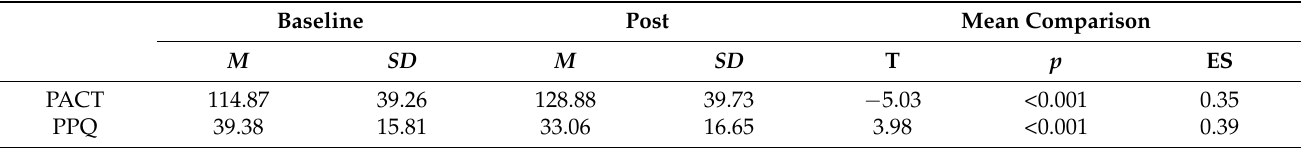
Table 4. Means and standard deviations of physical performance (PACT) and pain-related psycholog- ical impairment (PPQ) before and after outpatient orthopedic rehabilitation and effect sizes. Baseline Post Mean Comparison